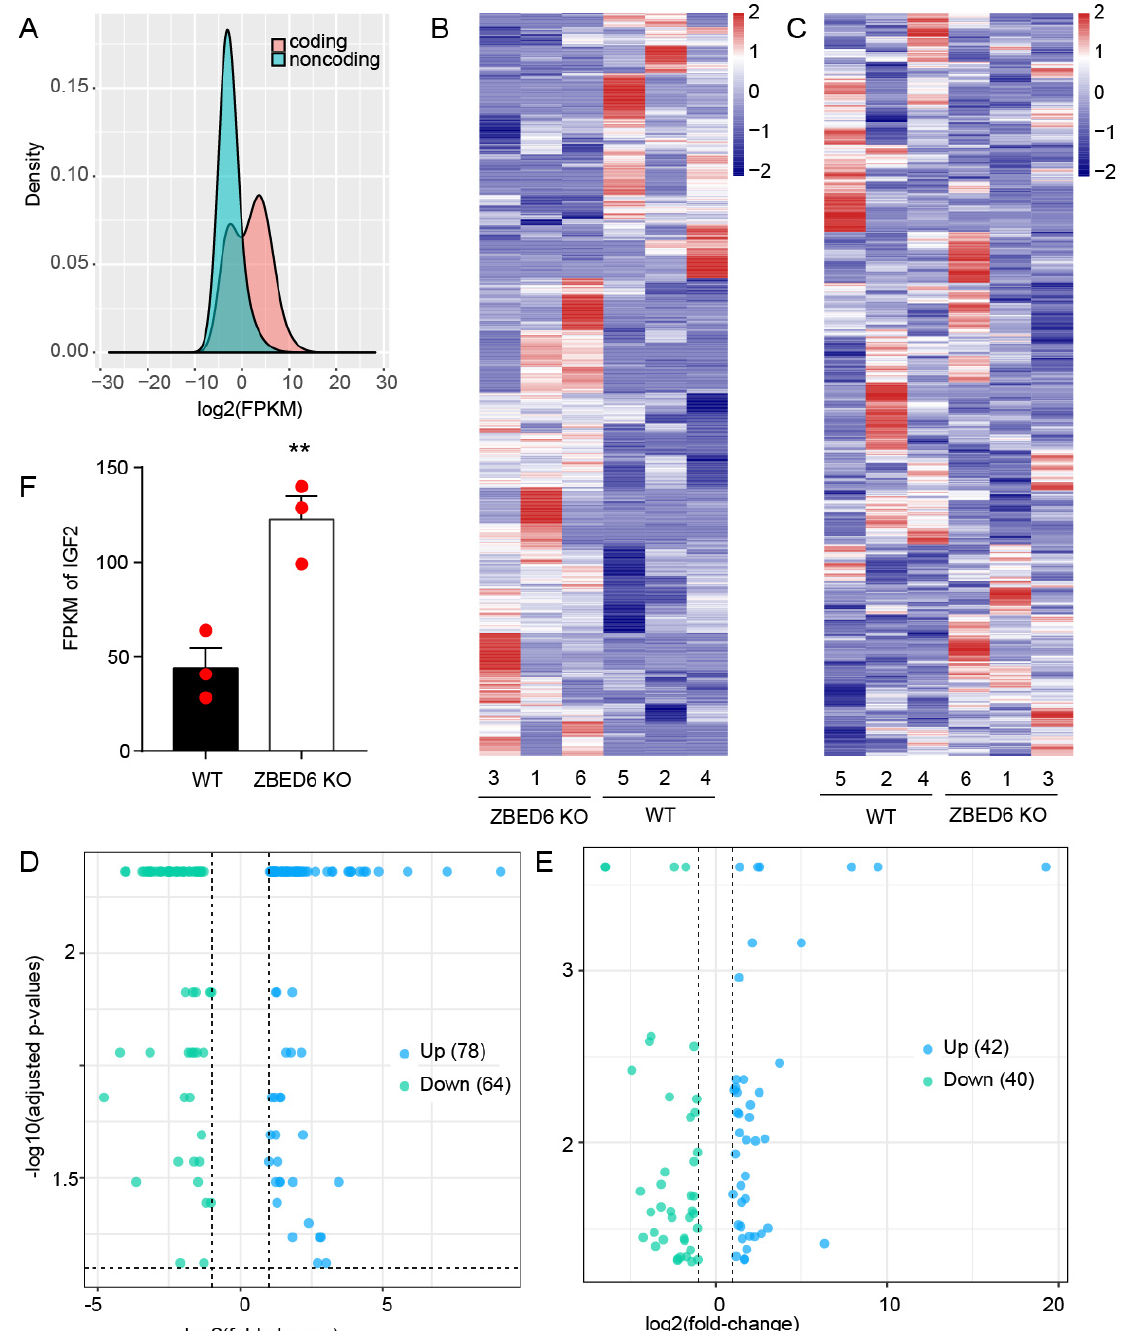
Figure 3. Differentially expressed mRNAs and lncRNAs. ( A ) Expression levels of mRNAs and lncRNAs. ( B , C ) Hierarchical clustering of mRNAs and lncRNAs. ( D , E ) Volcano plots of mRNAs and lncRNAs. ( F ) FPKM expression levels of IGF2 ; red points represent actual data. **, p < 0.01.